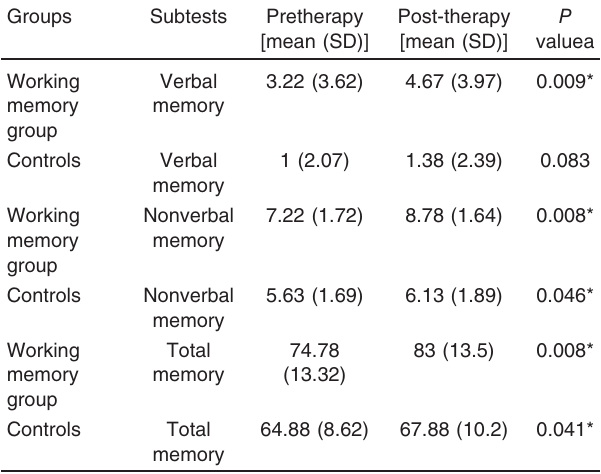
*Significant difference in post-therapy working memory variables (verbal, nonverbal, and total working memory) with P values of 0.03, 0.01, and 0.006,